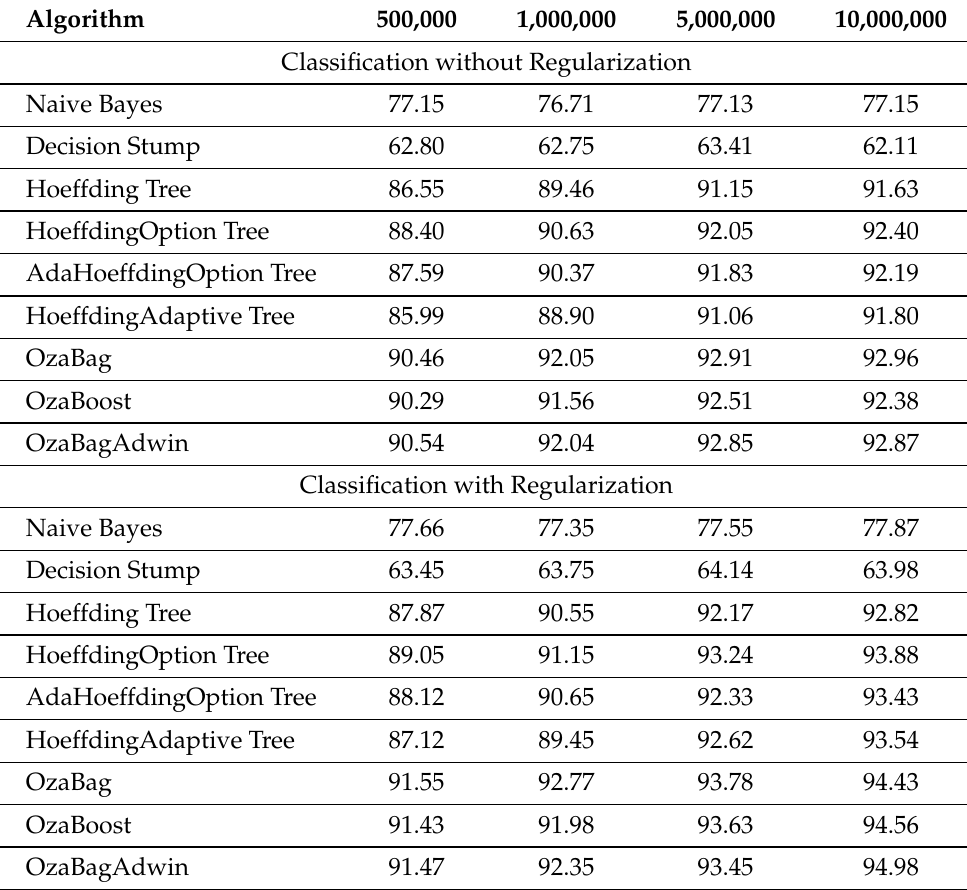
Table 9. Accuracy percentages of weather classification for different dataset sizes for training set =